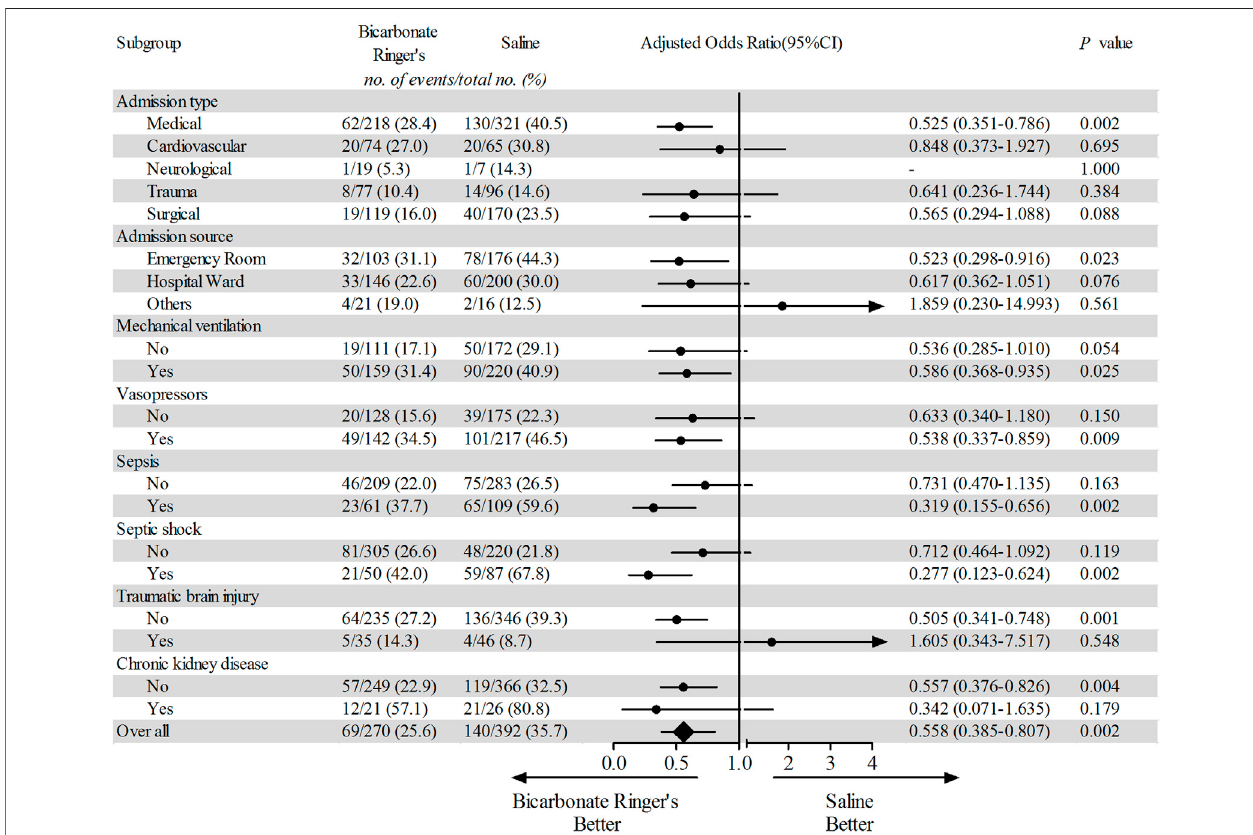
FIGURE 2 | Subgroup analysis of incidence for new receipt of renal replacement therapy.Forest plot shows the number, proportion, adjusted odds ratio and 95% con fi dence interval of all and subgroups ’ patients receiving new receipt of renal replacement therapy in the bicarbonate Ringer ’ s group and the saline group. The categorical outcomes were analyzed using the logistic regression model by adjusting the age, gender and sequential organ failure assessment (SOFA) score.